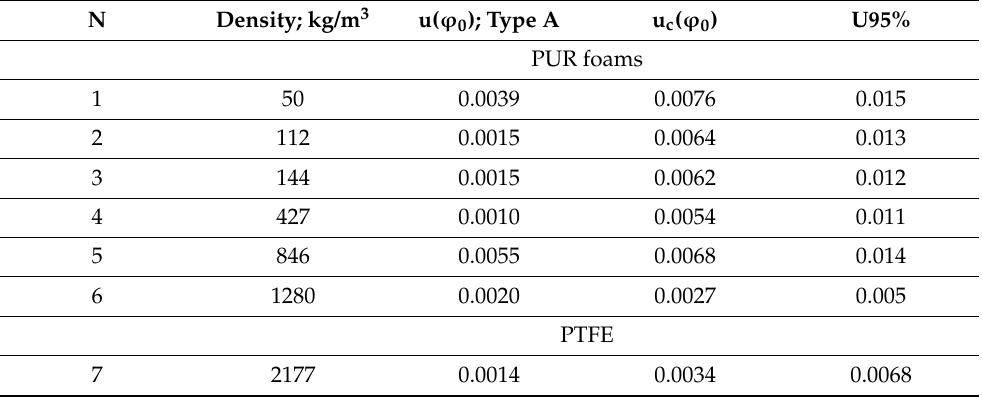
Table 6. Measurement uncertainties of dropping factor ϕ 0